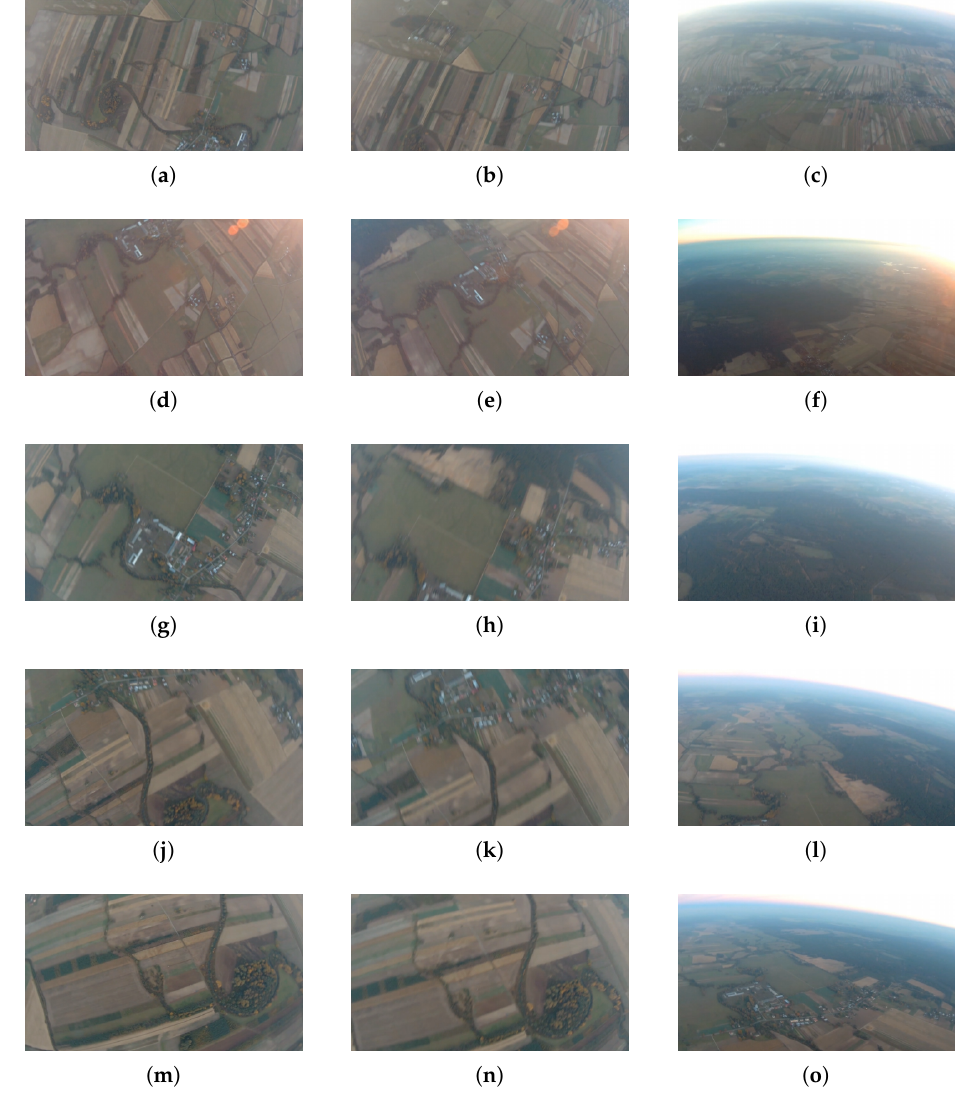
Figure 18. Selected frames from five spin executions: ( a – c ) 1st spin, ( d – f ) 2nd spin, ( g – i ) 3rd spin, ( j – l ) 4th spin, ( m – o ) 5th spin; columns correspond to spinning, diving and